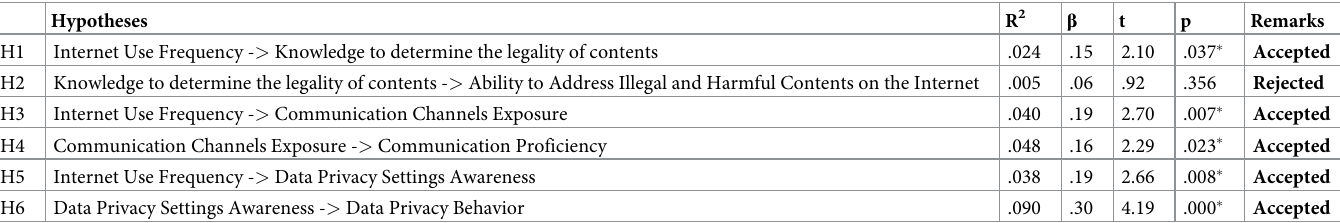
Table 4. Hypotheses